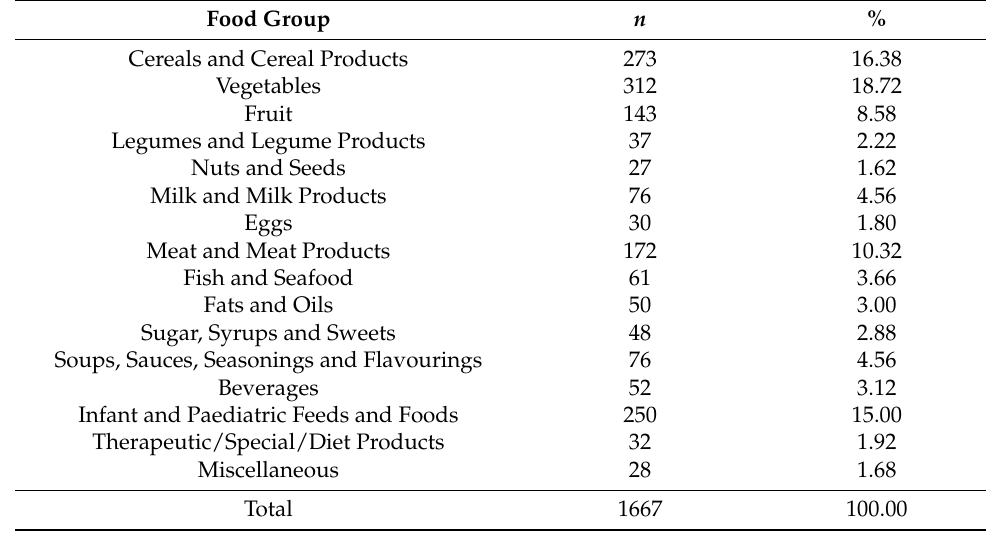
Table 1. Number of foods per food group.